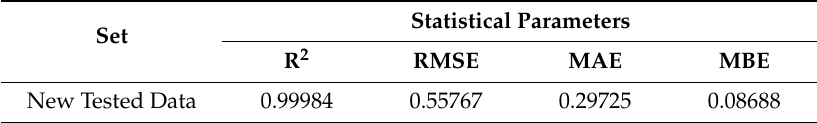
Table 11. Statistical parameters of the ANN12 model for the newly tested